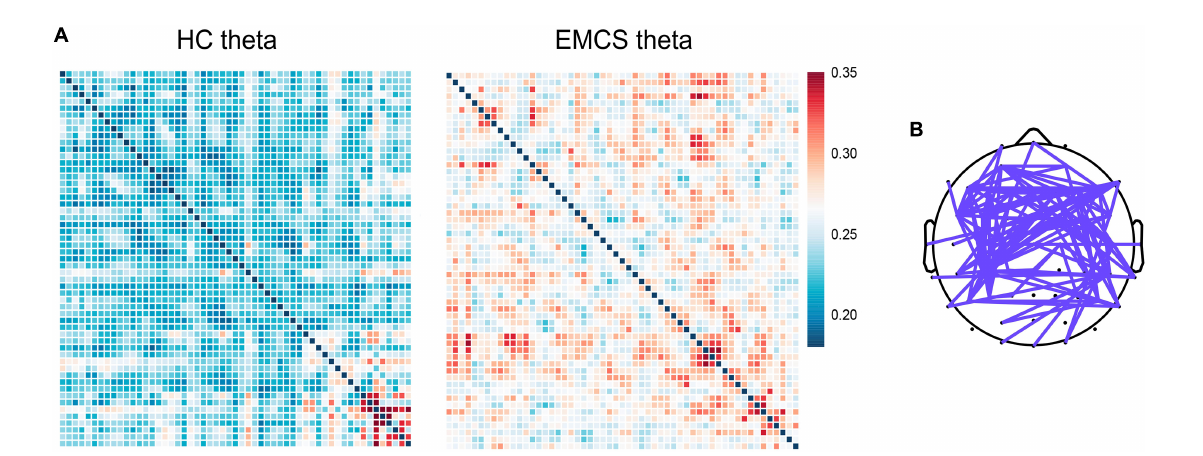
FIGURE3 Global weight phase lag index (wPLI) among healthy control (HC) group and emergence from minimally conscious state (EMCS) group. (A) Heatmaps of averaged wPLI values at rest for theta band between the groups. The wPLI values were implemented Fisher-Z transformed. (B) The top panel shows significantly altered connectivities between the two groups. The purple line means significantly increased connectivity in EMCS